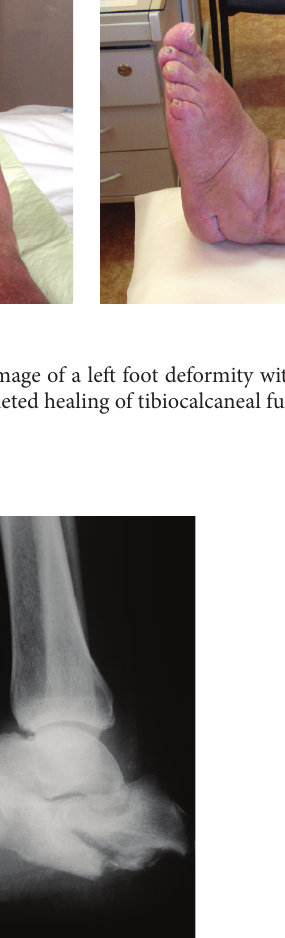
Figure 8: A lateral X-ray image of calcaneus: the pull of the Achilles tendon causes the fragment to be dislocated, with incongruence in the subtalar